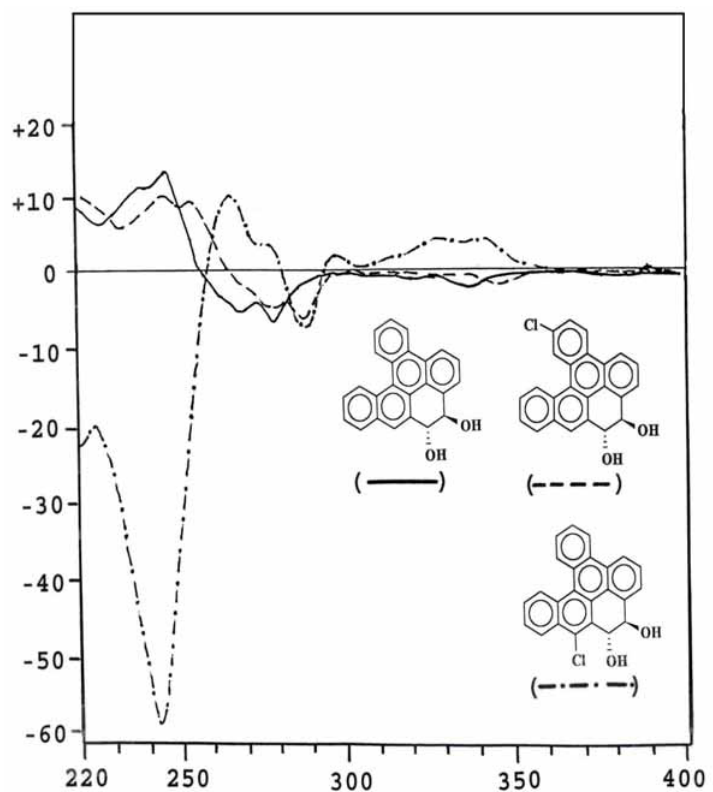
Figure 3. CD spectra of DB[ a,l ]P trans -8,9-dihydrodiol, 2-Cl-DB[ a,l ]P trans -8,9-dihydrodiol, and 10- Cl-DB[ a,l ]P trans -8,9-dihydrodiol.